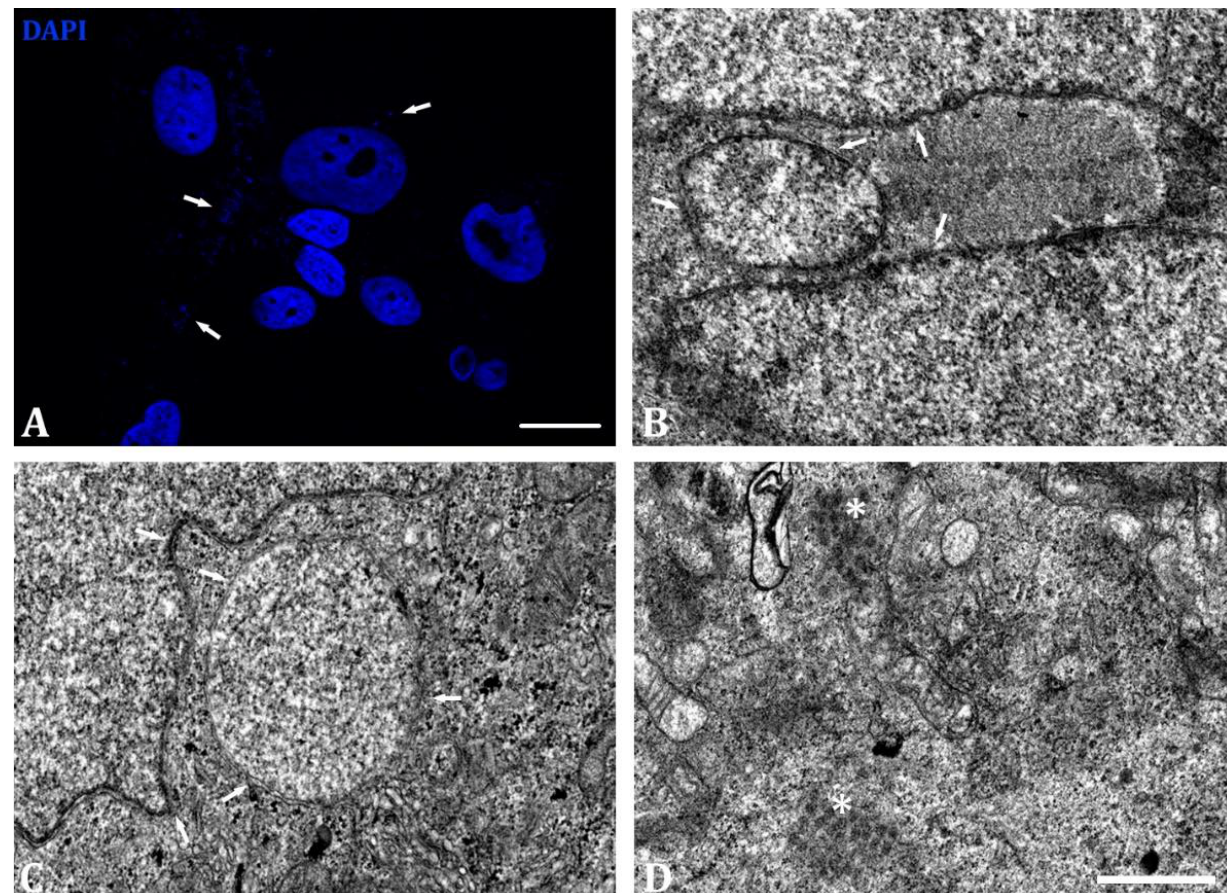
Figure 4 . Ultrastructural analysis of membranous chromatin inclusions observed in the cytoplasm of TC7 Cbx3 KO cells. ( A ) Evidence for the presence of DNA - containing structures in the cytoplasm by staining with DAPI. ( B,C ) Examples of chromatin - containing double - membraned cytoplasmic inclusions (double membrane featured by arrows) observed in TC7 Cbx3 KO cells. While these inclusions are located close to the nuclear envelope, they are not in direct contact with it. ( D ) Detail of free chromatin structures (asterisk) observed in the cytoplasm of cells lacking HP1γ. These structures are found free in the cytoplasm, with no preference for any organelle or nuclear substructure. n = 5 clones (generated by 1 sgRNA) per condition. Scale bar: ( A ) 25 µm; ( B – D ) 400 nm. In TC7 Cbx3 KO cells, we observed the induction of numerous DNA damage foci, which were la- beled by γH2AX (Figure 5E). The analysis revealed that 93.8% of the cells were positive for these DNA damage foci (Figure 5G). In contrast, the DNA damage foci in TC7 wild - type cells were much smaller and were present in only 16.3% of the total cells (Figure 5B,G), possibly due to sporadic DNA damage [22,23]. Lastly, the phenotype was found reversible by the stable reintroduction of HP1γ expression in TC7 Cbx3 KO cells. Indeed, the appearance of laminopathy as well as the for- mation of γH2AX - positive cells were significantly reduced (Supplementary Figure S4(C1–C3,D1– D3)). Additionally, the formation of γH2AX - positive cells remained at similar levels as in TC7 WT cells (Supplementary Figure S4 (D1–D4)).